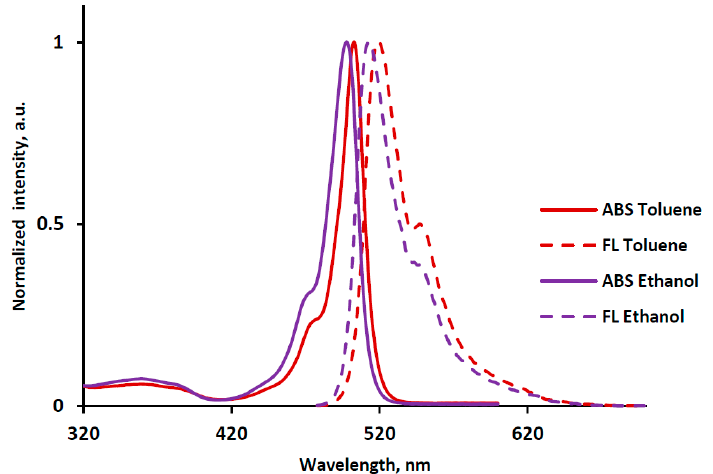
Figure 2. Normalized electronic absorption and emission spectra of [BF 2 L] solution in organic solvents.